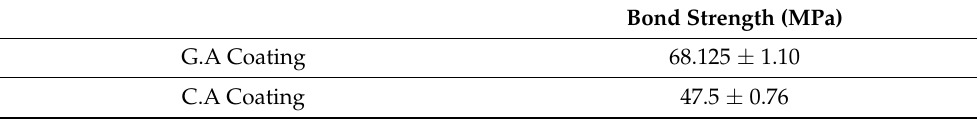
Table 7. Bond strengths of the coatings.